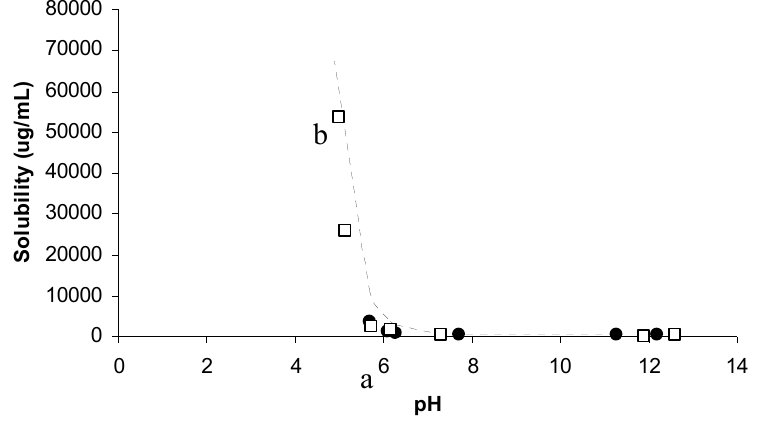
Figure 13. pH solubility profile of TMP and TMP-glutamate salt at ambient conditions using free acid (circles) and TMP-glutamate salt (squares) as starting materials. Points b and a represent the saturation solubility of the salt and TMP free base respectively. [Bs] = 266.35µg/mL and pKa =